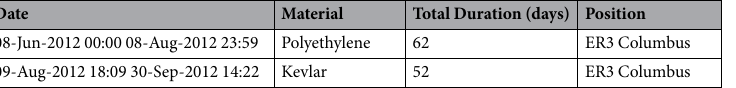
Table 1. Schedule of the ALTEA – shield project. Data taking periods are reported in the first column for the two materials listed in the second column. The total duration includes short ‘off’ periods due to many causes such as maintenance and transient electronic failures. The measurement site was inside the Express Rack 3 (ER3) in the Columbus module of the International Space Station. Kevlar measurement period ended